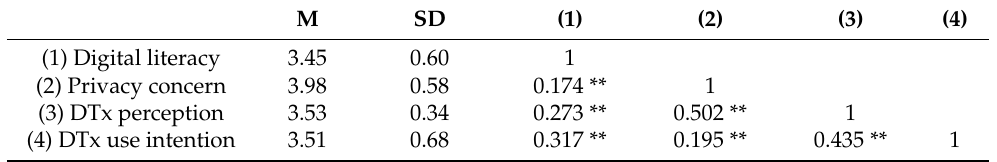
Table 1. Means, standard deviations, and Pearson correlations among predictors of DTx use